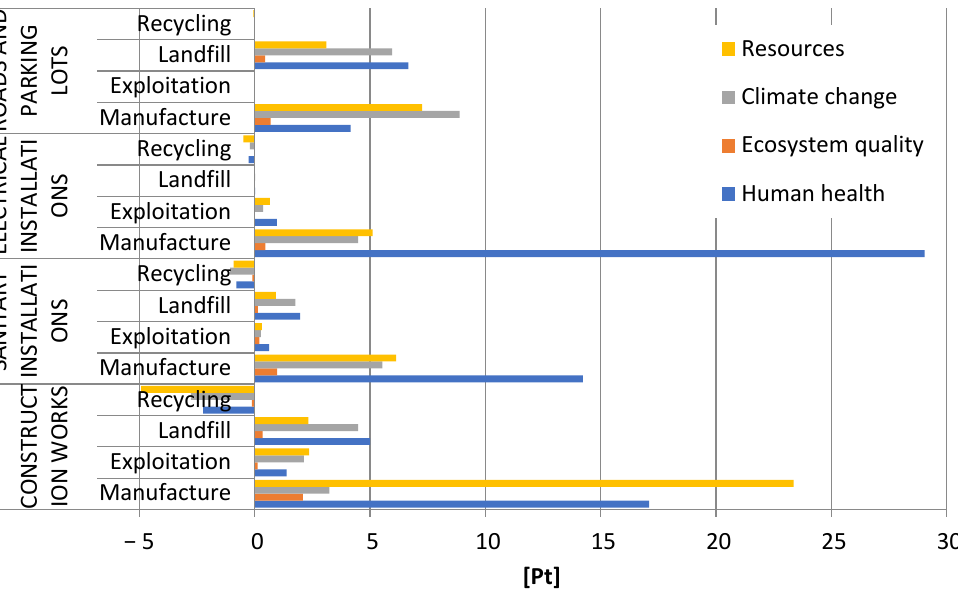
Figure 20. The results of grouping and weighing the environmental consequences occurring at individual stages of the life cycle of the research object by areas of influence.